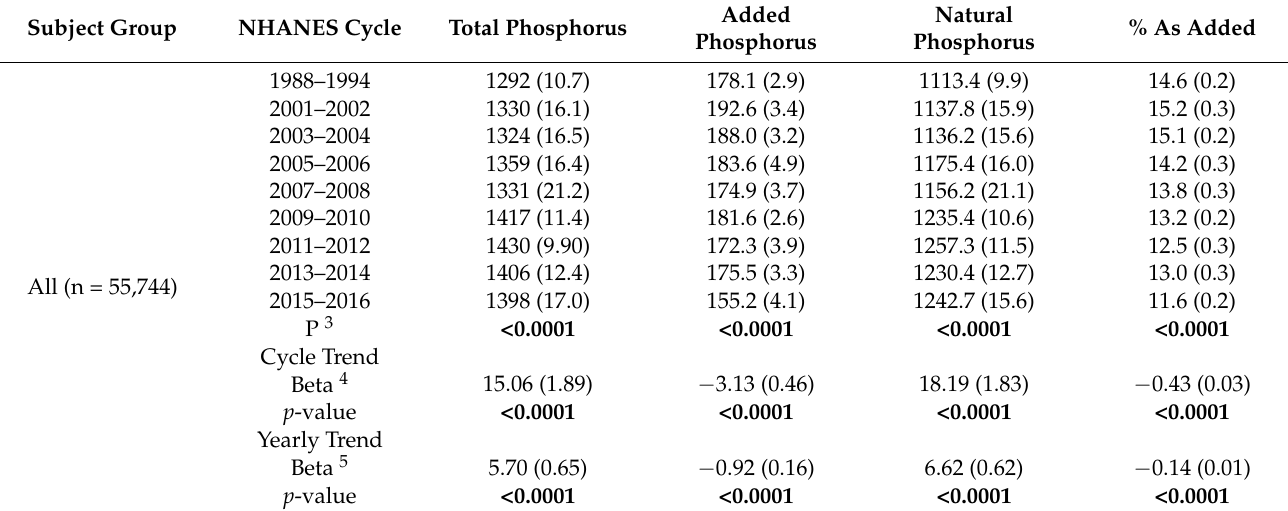
Table 1. Total, added, and natural phosphorus mean 1,2 intake (mg/day) and percentage of total phosphorus as added for adults 19 years of age and older, the NHANES 1988–1994 and